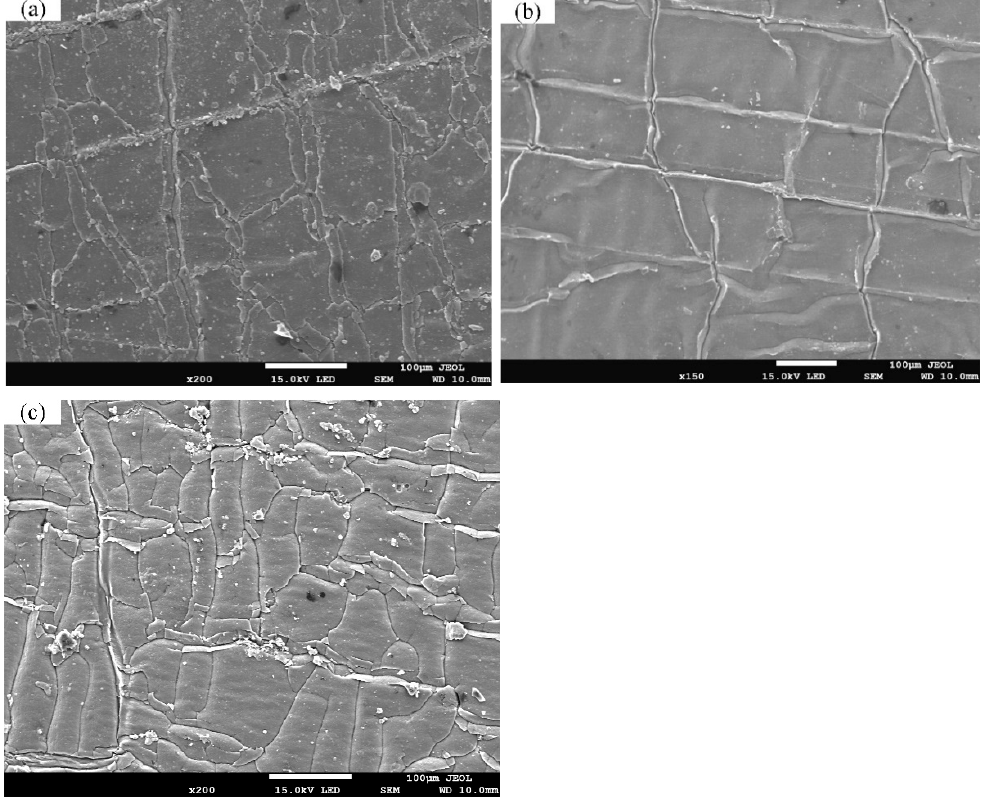
Figure 2. SEM images show the overview of patch-like networks of (Ti:N)-GLC films: ( a ) Ti-C (100); ( b ) TiC-C (100); ( c ) TiN-C (100).